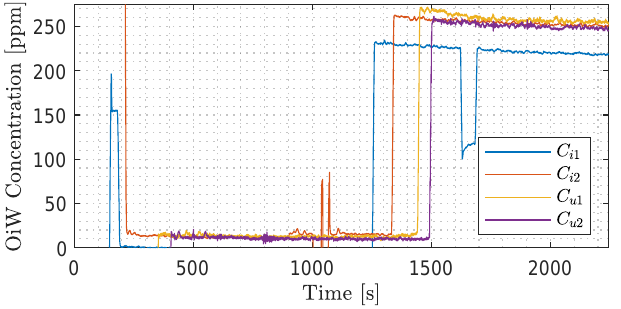
Figure 15. The four OiW monitors injected with 0 ppm at ∼ 250 s then 250 ppm after ∼ 1250 s. The four monitors’ measured ppm were reasonable and similar for the injected